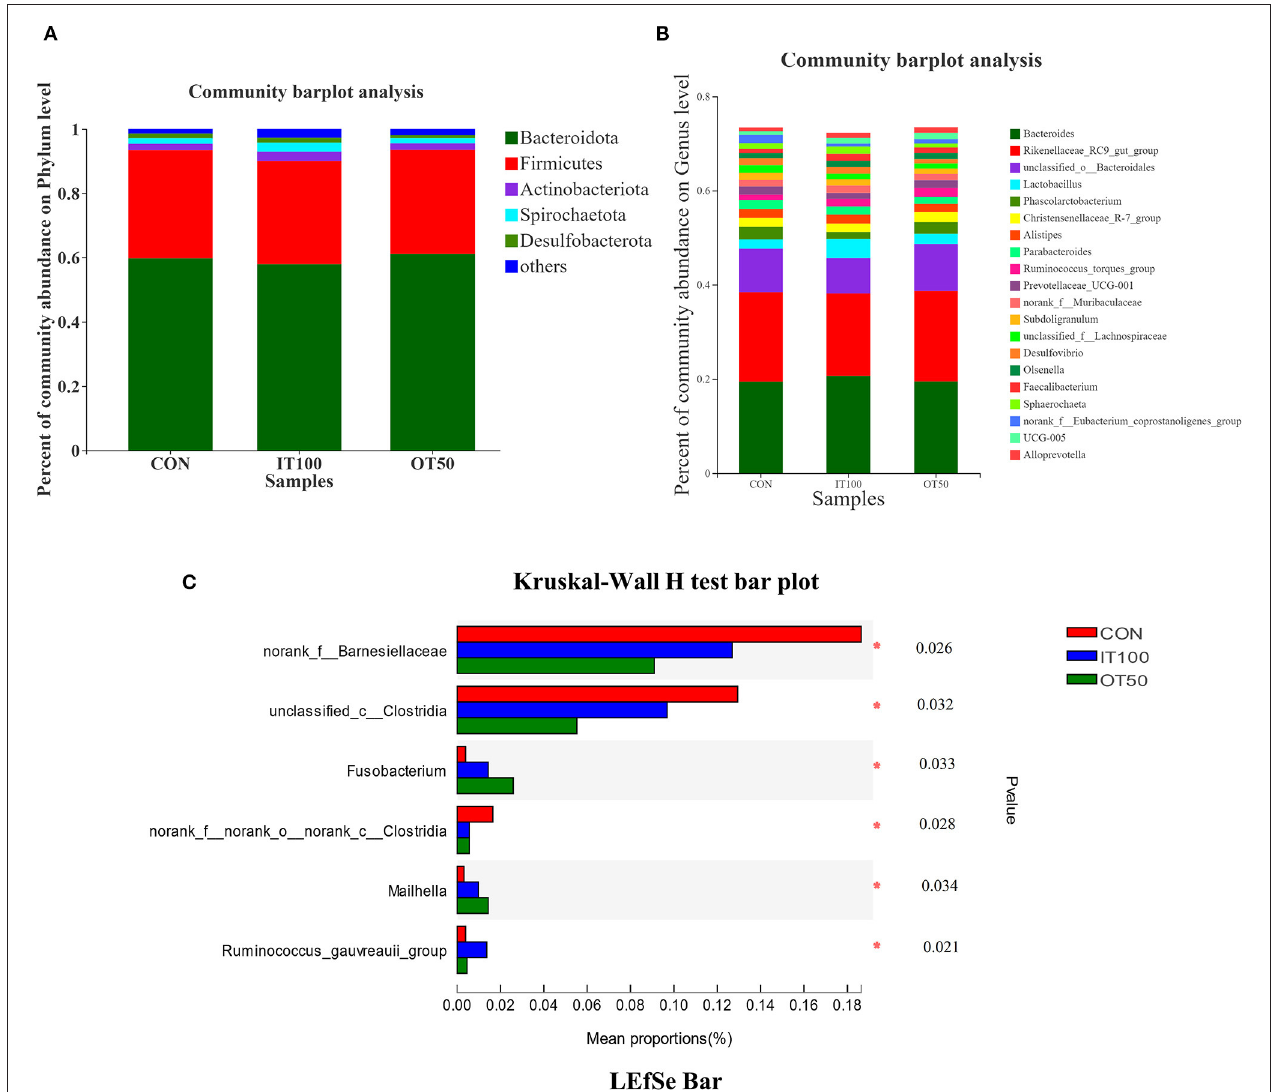
FIGURE 3 | Effects of inorganic and low level of organic trace minerals on the caecal microbiota at the 8th week of the experiment with hen layer at the age of 67 weeks ( n = 6). (A,B) No significant change was observed at phylum level and top 20 genus; (C) Barnesiellaceae and Clostridia were significantly decreased by supplement of inorganic or organic trace elements. CON, control treatment, basal diet without supplementation; IT 100, inorganic treatment 100%, basal diet with 100% Cu-Zn-Mn-Fe supplementation as sulfates; OT 50, organic treatment 50%, basal diet with 100% Cu-Zn-Mn-Fe supplementation as amino acid chelates. The asterisk symbol (*) means significantly different ( P <